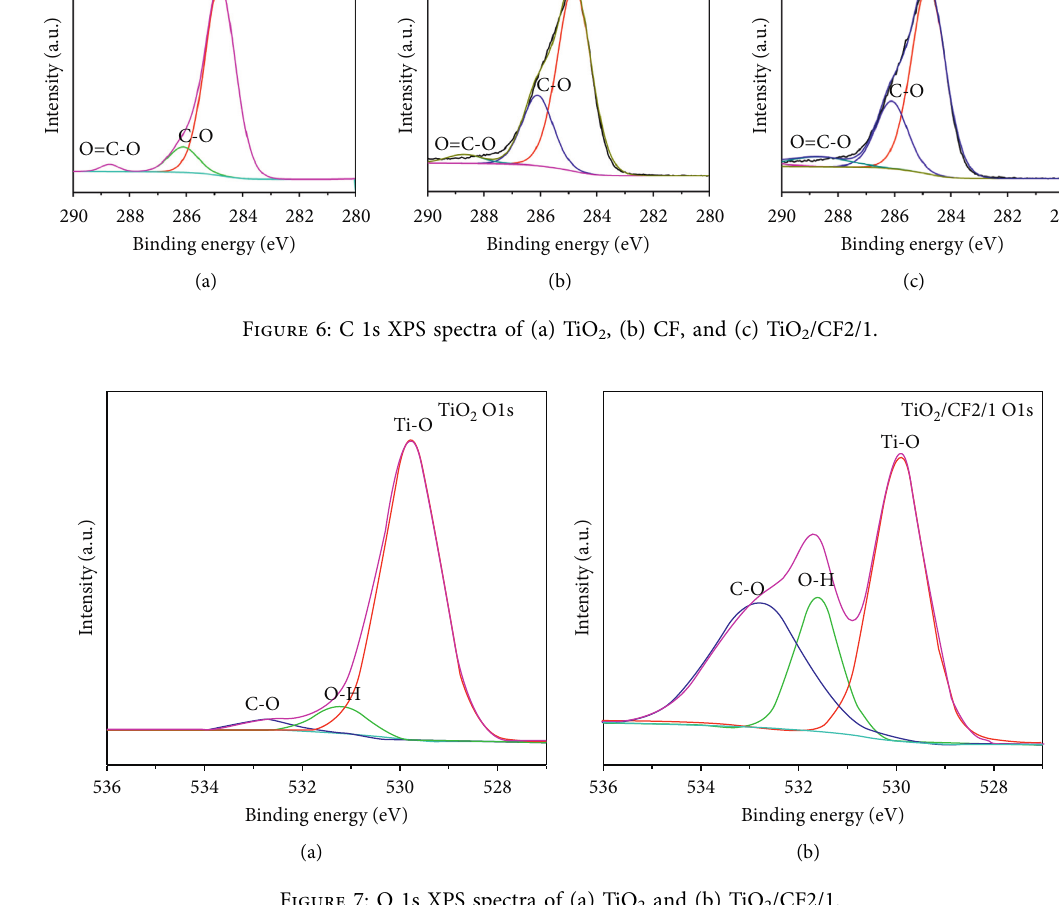
2 and (b) TiO 2 /CF2/1.